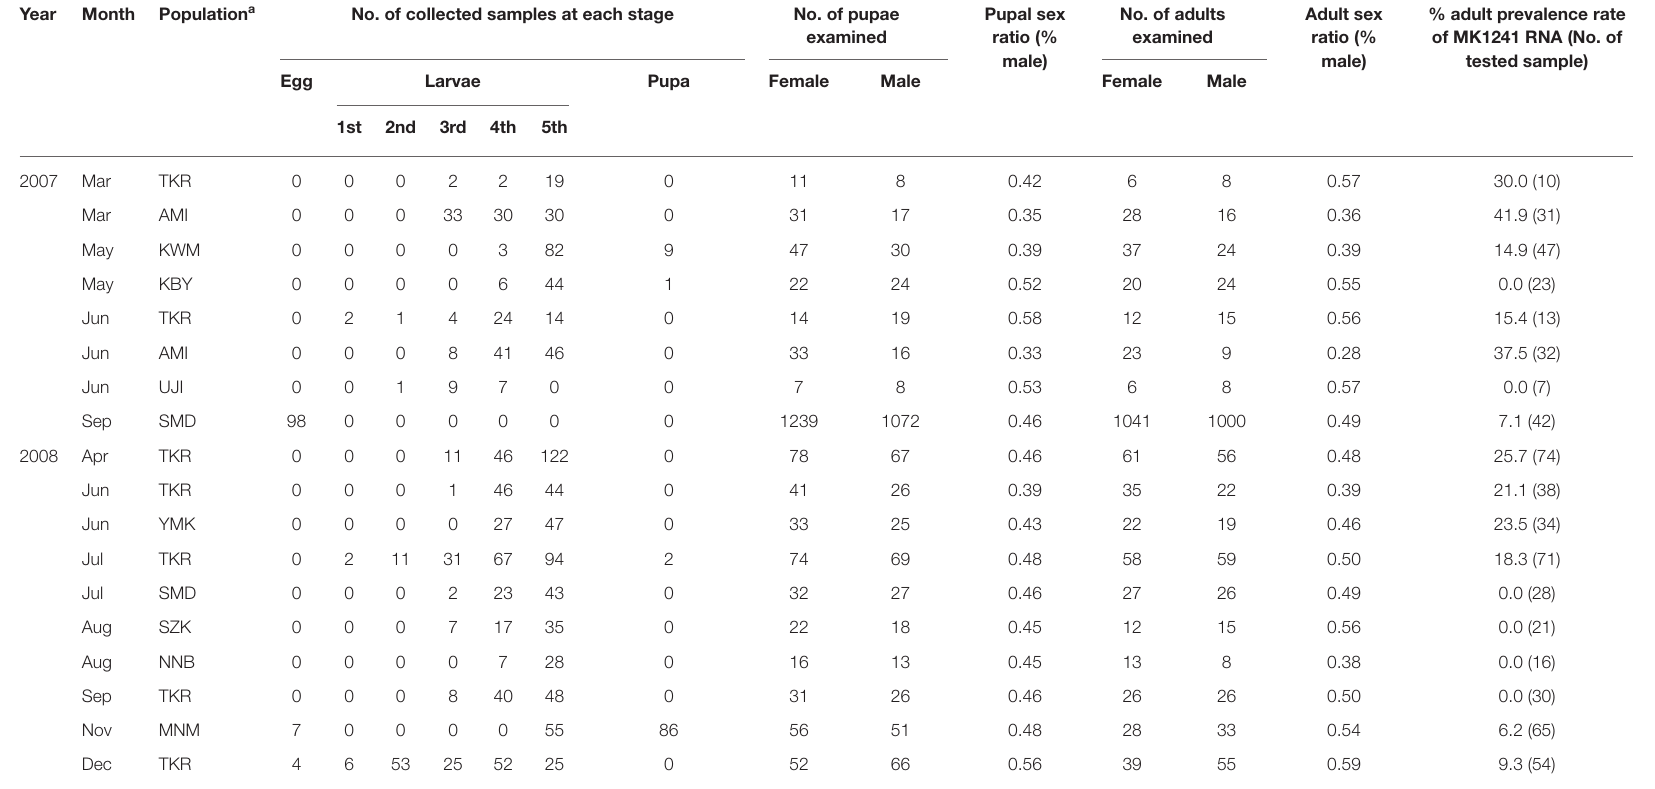
a For the abbreviations, see Supplementary Figure 1